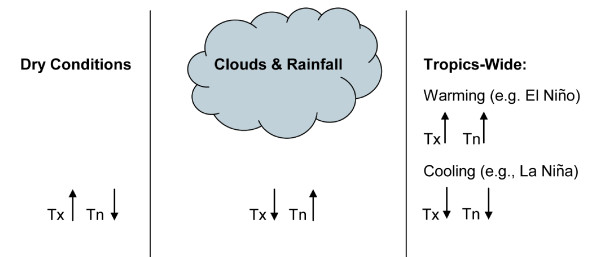
Schematic of the relationship between Tx and Tn with unusually dry conditions (left), rainy conditions (center) and in relationship to tropics-wide warming or cooling associated with El Niño or La Niña (right).